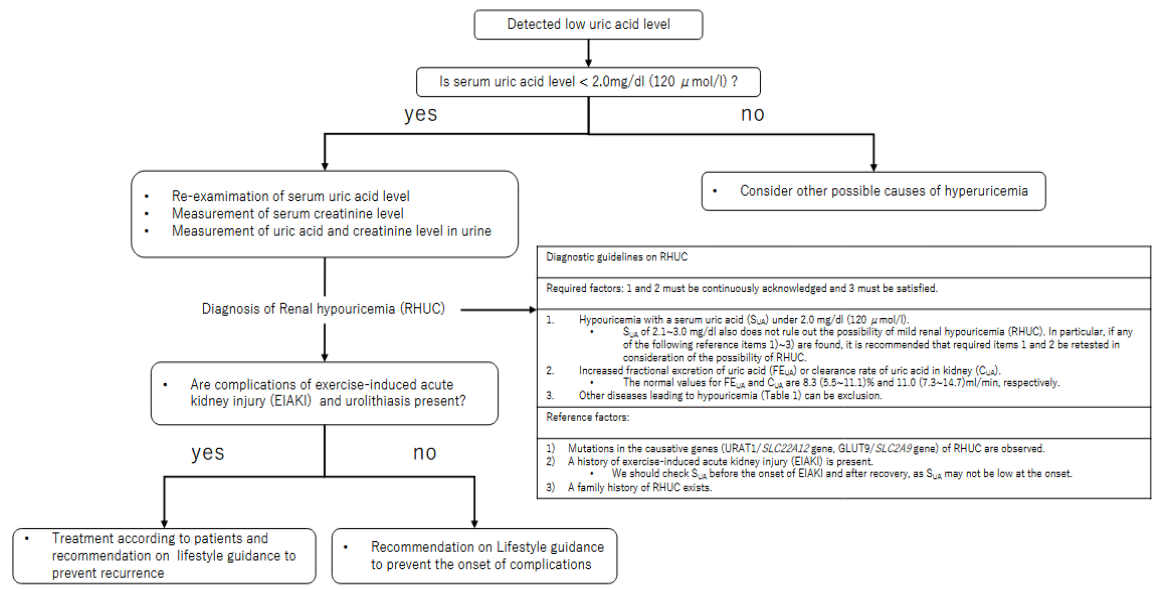
Figure 1. Flowchart for diagnosing RHUC in routine clinical practice. When low serum uric acid levels are detected, especially when the value is <2.0 mg/dL, uric acid and creatinine levels in blood and urine should be retested, and a diagnosis should be made based on the diagnostic guidelines on renal hypouricemia (RHUC). Modified from Nakayama et al. [34] under the terms of the